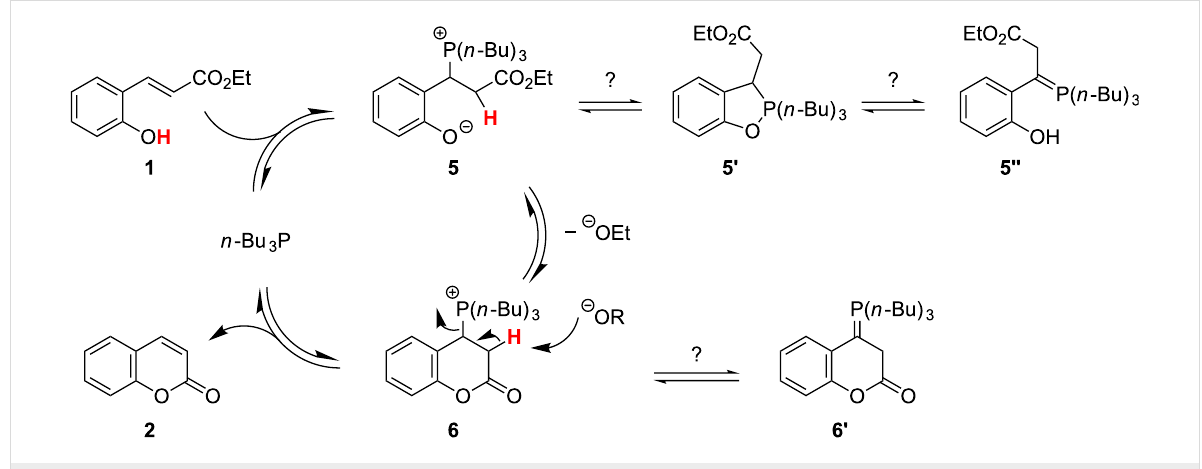
Scheme 3: Proposed catalytic cycle, based on 31 P NMR spectroscopic and color